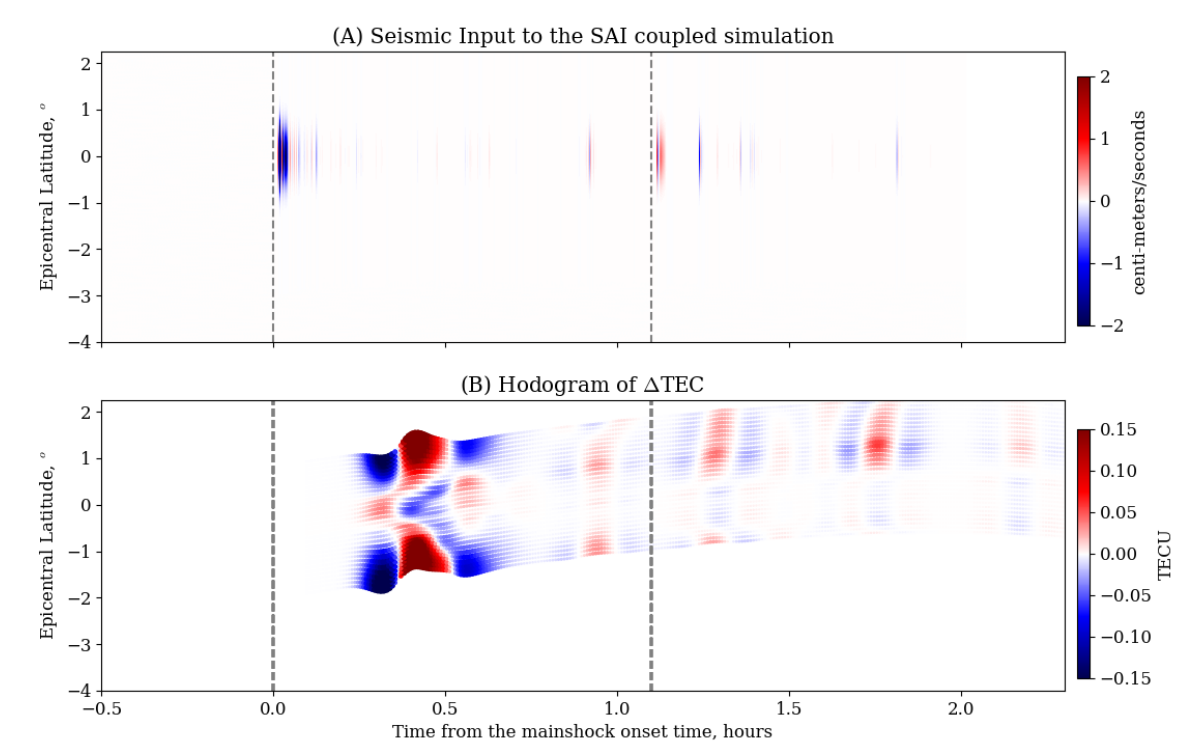
Figure 8. Simulation results from the SAI coupling model: ( A ) the ground vibration at the epicenter, composed of a mainshock at t = 0.0 and a series of aftershocks.( B ) A hodogram of the simulated ∆ TEC. The hodogram was constructed by estimating the simulated ∆ TEC along the IPP trajectories of the hodogram in Figure